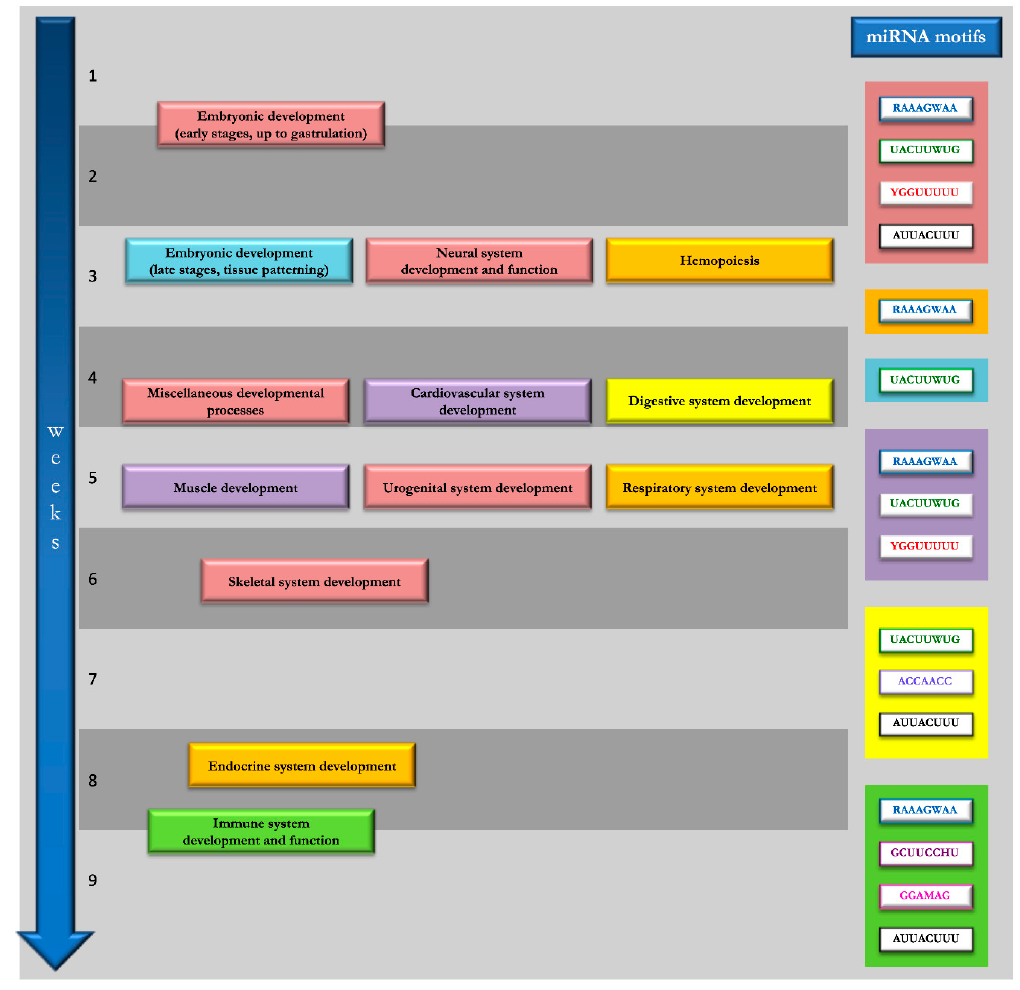
Figure 2. Schematic representation of spatial and temporal distribution of putative DNA-binding motifs identified in microRNAs (miRNAs). The functional clusters identified with the computational pathway analysis of transcription factors (TFs) sharing the motifs identified in miRNAs are depicted as colored boxes distributed along the timeline (arrow on the left side) of human embryo development. The colored boxes (right side; same color ID scale) group the motifs identified in miRNAs for which developmental functions were enriched, according to GeneMANIA functional interpretation (see text for details).